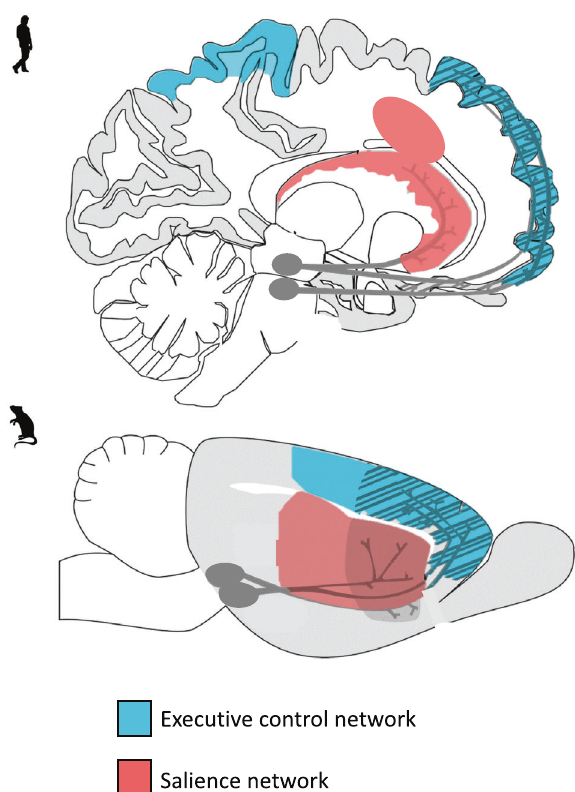
Fig. 1 Translational brain models of addiction. A visual represen- tation of the translational model of the executive control and salience networks in humans and rodents. The executive control and salience are key networks believed to play a part in adolescent vulnerability to alcohol-related